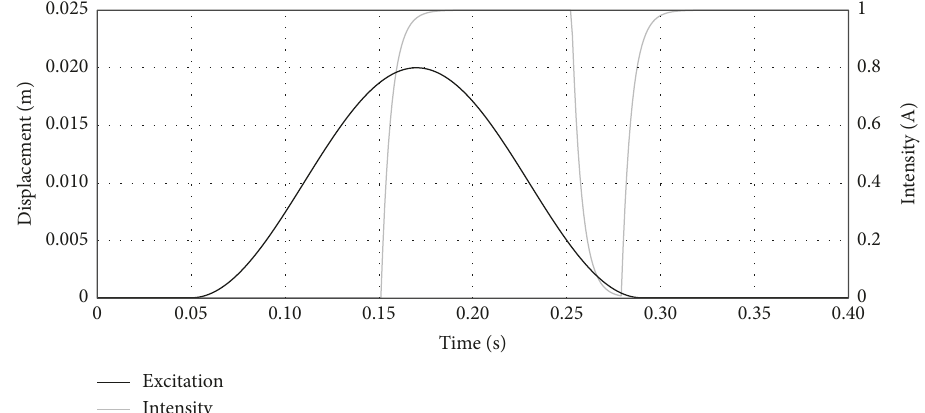
Figure 17: Temporal excitation corresponding to a bump with H � 0 . 02 m and L � 1m travelled at v � 15km/h and example of the current required by the skyhook control system.